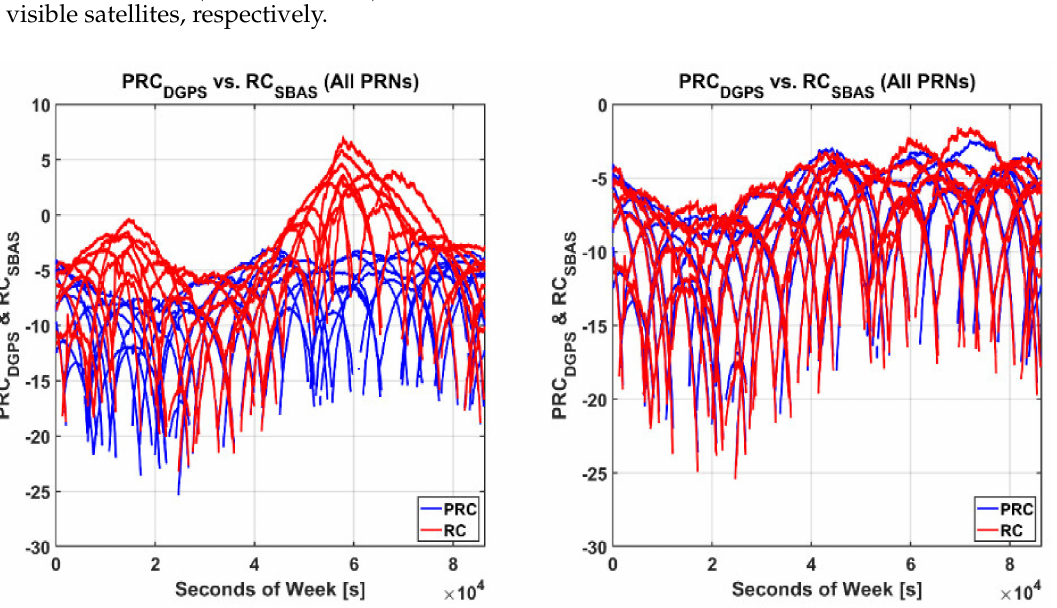
Figure 6. Comparison between pseudo range correction (PRC) and range correction (RC) before ( left ) and after removing bias ( right